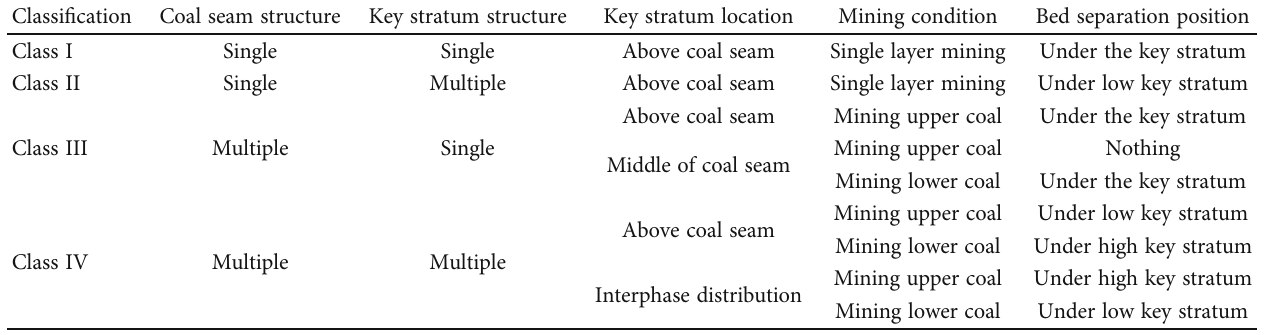
Figure 11: Classi fi cation of overburden structure of bed separation zone under key stratum. Table 4: Classi fi cation of overburden structure.